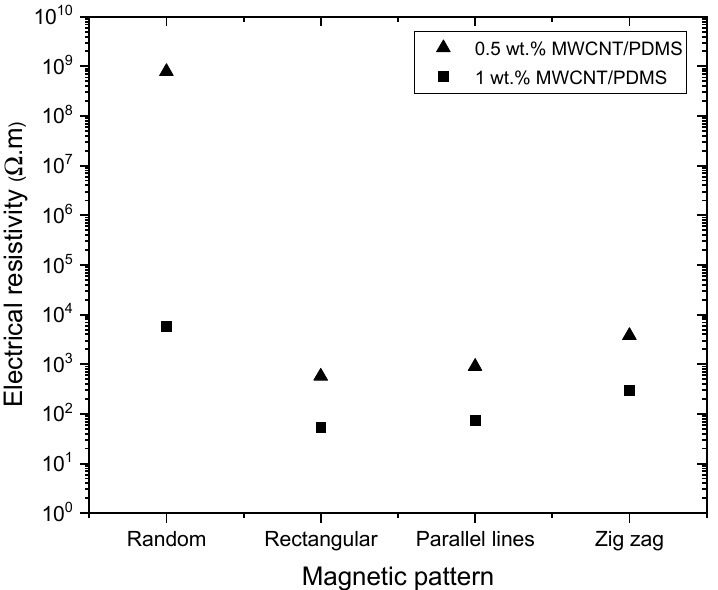
Figure 11. Electrical resistivity of the nanocomposites fabricated with different magnetic patterns.